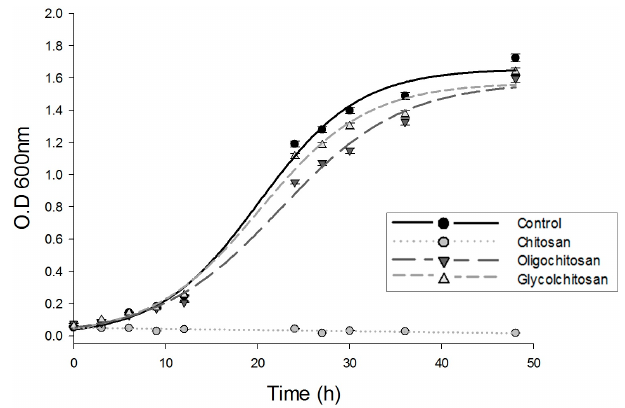
Figure 1. Growth of Ustilago maydis in minimal medium and in the presence of chitosan, oligochitosan or glycol-chitosan. Each agent was added to a fi nal concentration of 1 mg · mL − 1 . Growth was measured as an increase in optical density at 600 nm.